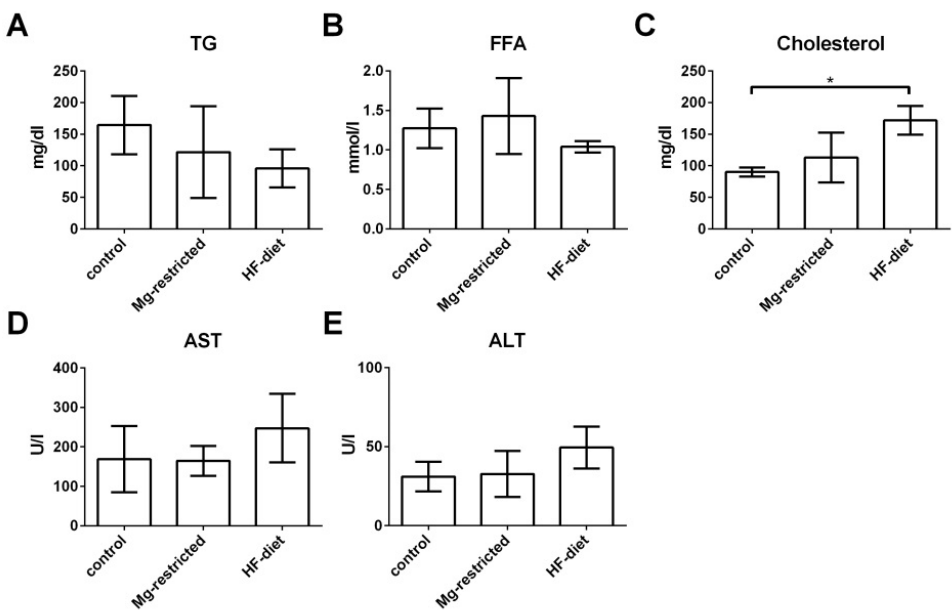
Figure 3. Influence of Mg-restriction and HF-diet feeding on metabolic serum parameters and serum markers of liver function. Levels of TG, FFA, total cholesterol, and transaminases AST and ALT determined out of serum, resulting in no significant changes in ( A ) TG and ( B ) FFA, while ( C ) total cholesterol levels are significantly increased in HF-diet fed mice. Serum levels of ( D ) AST and ( E ) ALT are not altered due to dietary treatments. Given are means with standard deviations and relevant significant differences are marked with an * ( p values of < 0.05 by one-way ANOVA followed by Dunnett’s multiple comparisons test).